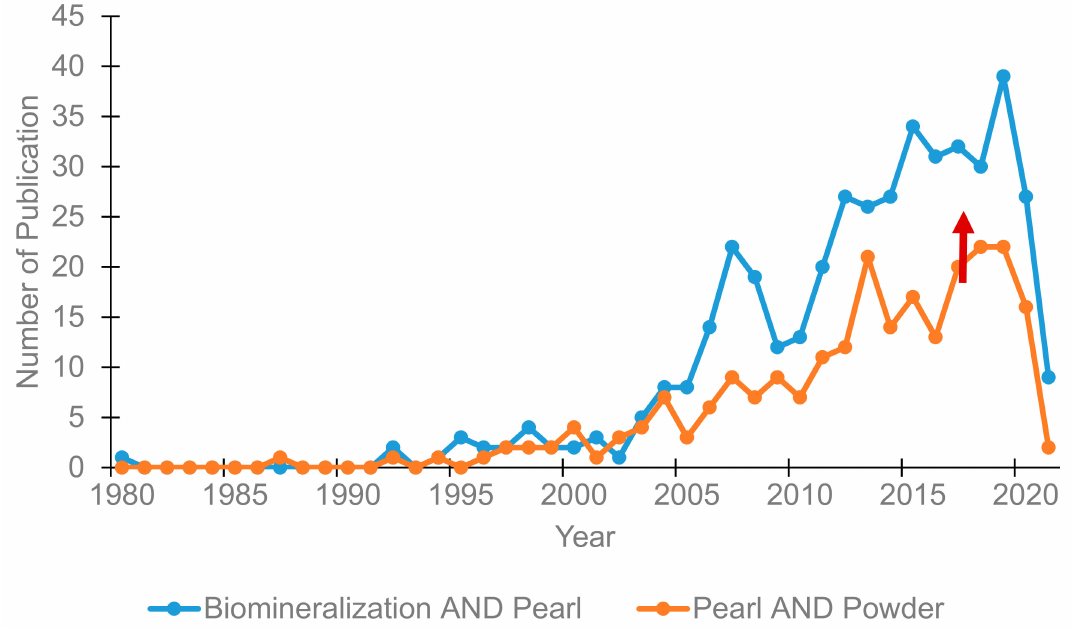
Figure 1. Number of publications per year from the Web of Science search for articles with topics of search terms “Biomineralization AND Pearl” and “Pearl AND Powder”, dated 16 April